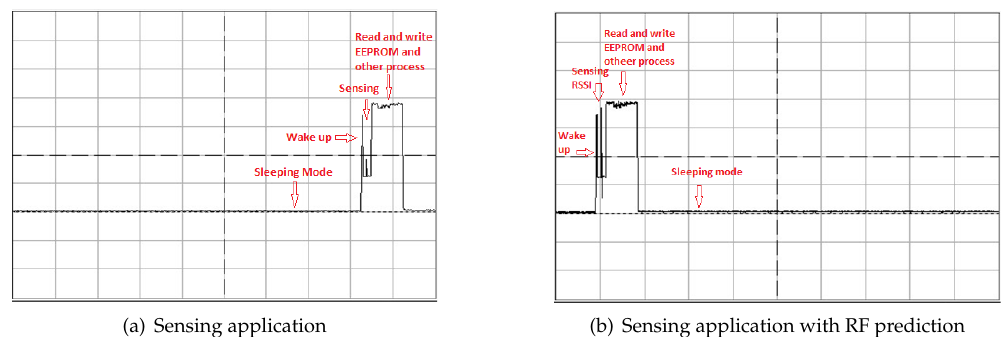
Figure 2: Energy consumed by the sensor node when running our algorithm Our algorithm consumed 9.2X10 -5 J as shown in Fig. 2